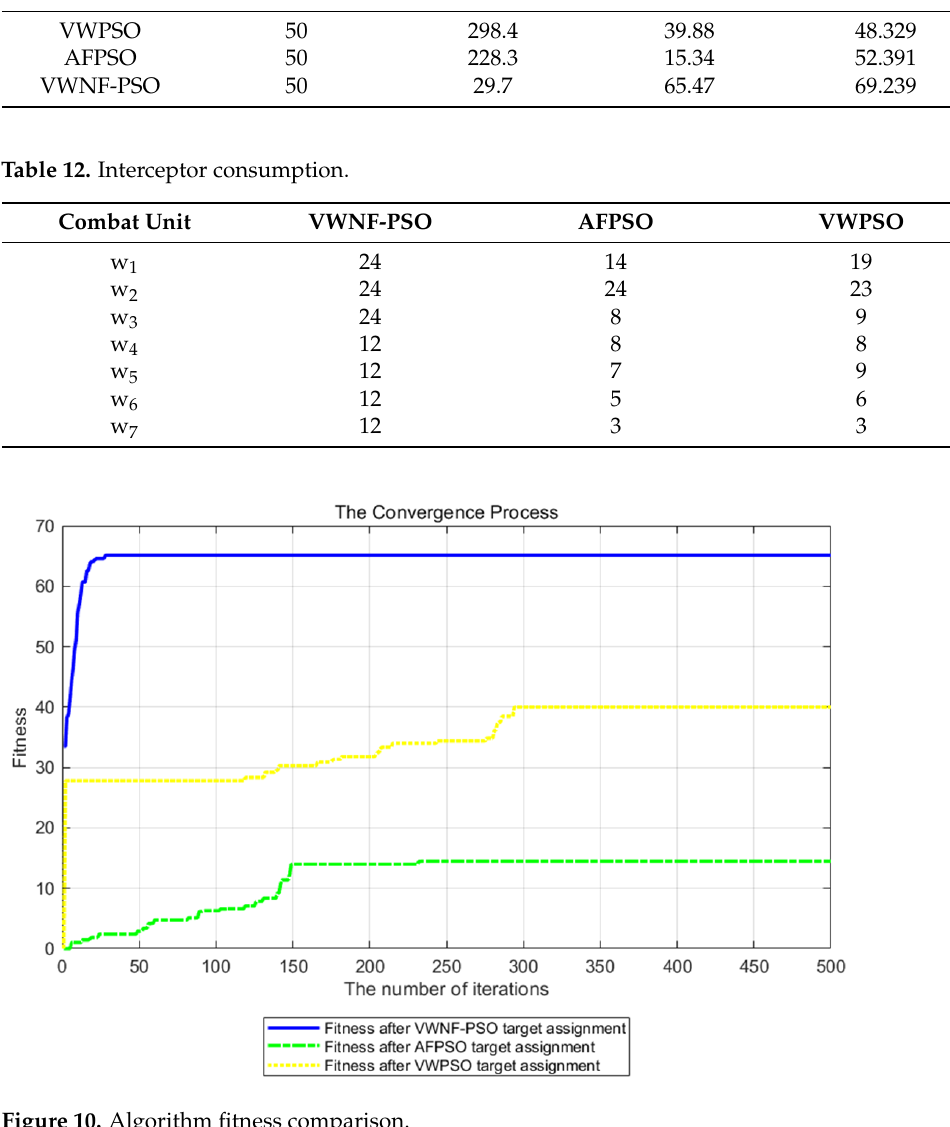
Figure 10. Algorithm fitness comparison.